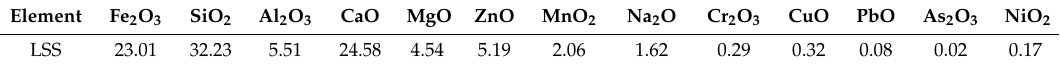
Figure 1. Particle size distribution of the lead smelting slag (LSS) after ball milling. Table 1. Chemical compositions of the LSS (wt.%).